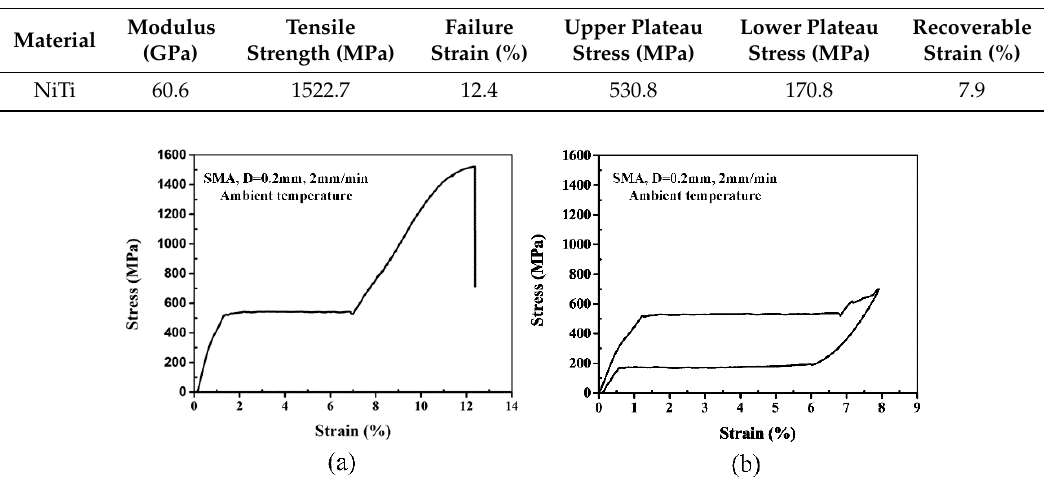
Figure 1. Tensile testing of SMA wires [24]: ( a ) Representative tensile stress-strain curve of SMA wires at breakage and ( b ) superelastic deformation of SAM wires.